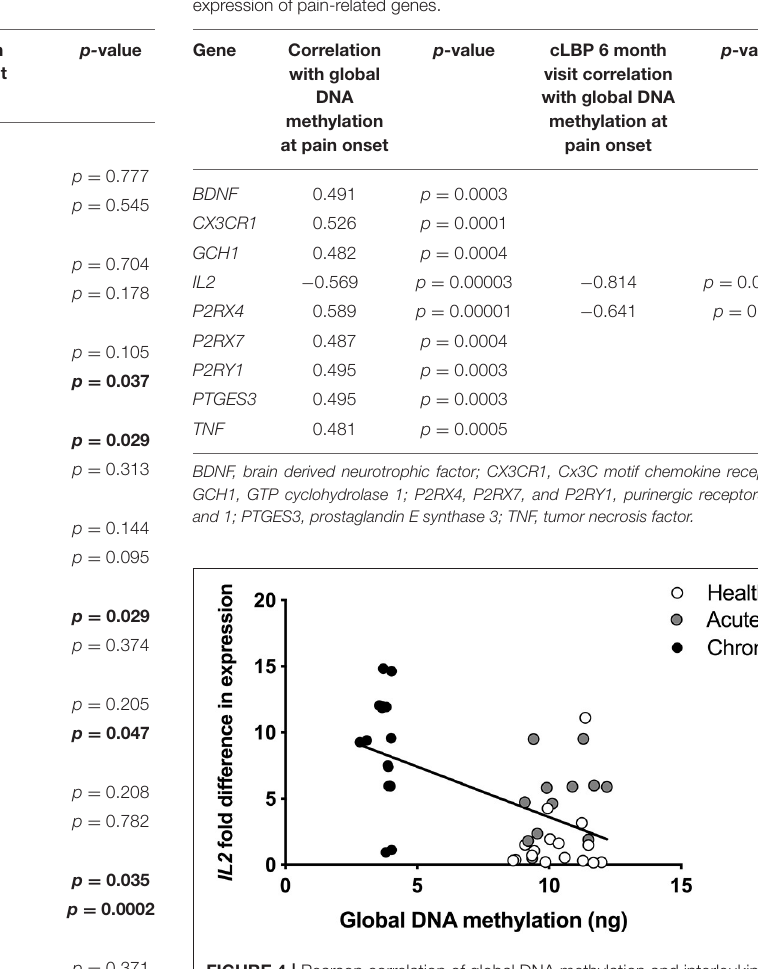
FIGURE 4 | Pearson correlation of global DNA methylation and interleukin 2 ( IL2) expression in blood collected at the time of pain onset. r p = − 0.569.